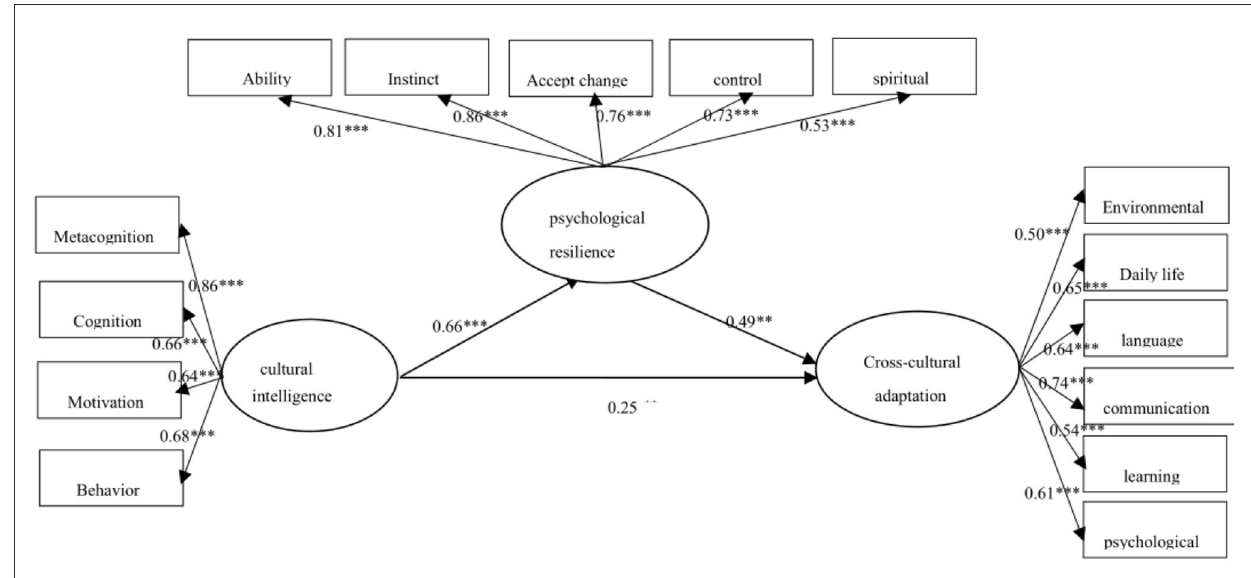
FIGURE1 Mediation effect model. Note. ** p < 0.01, *** p <